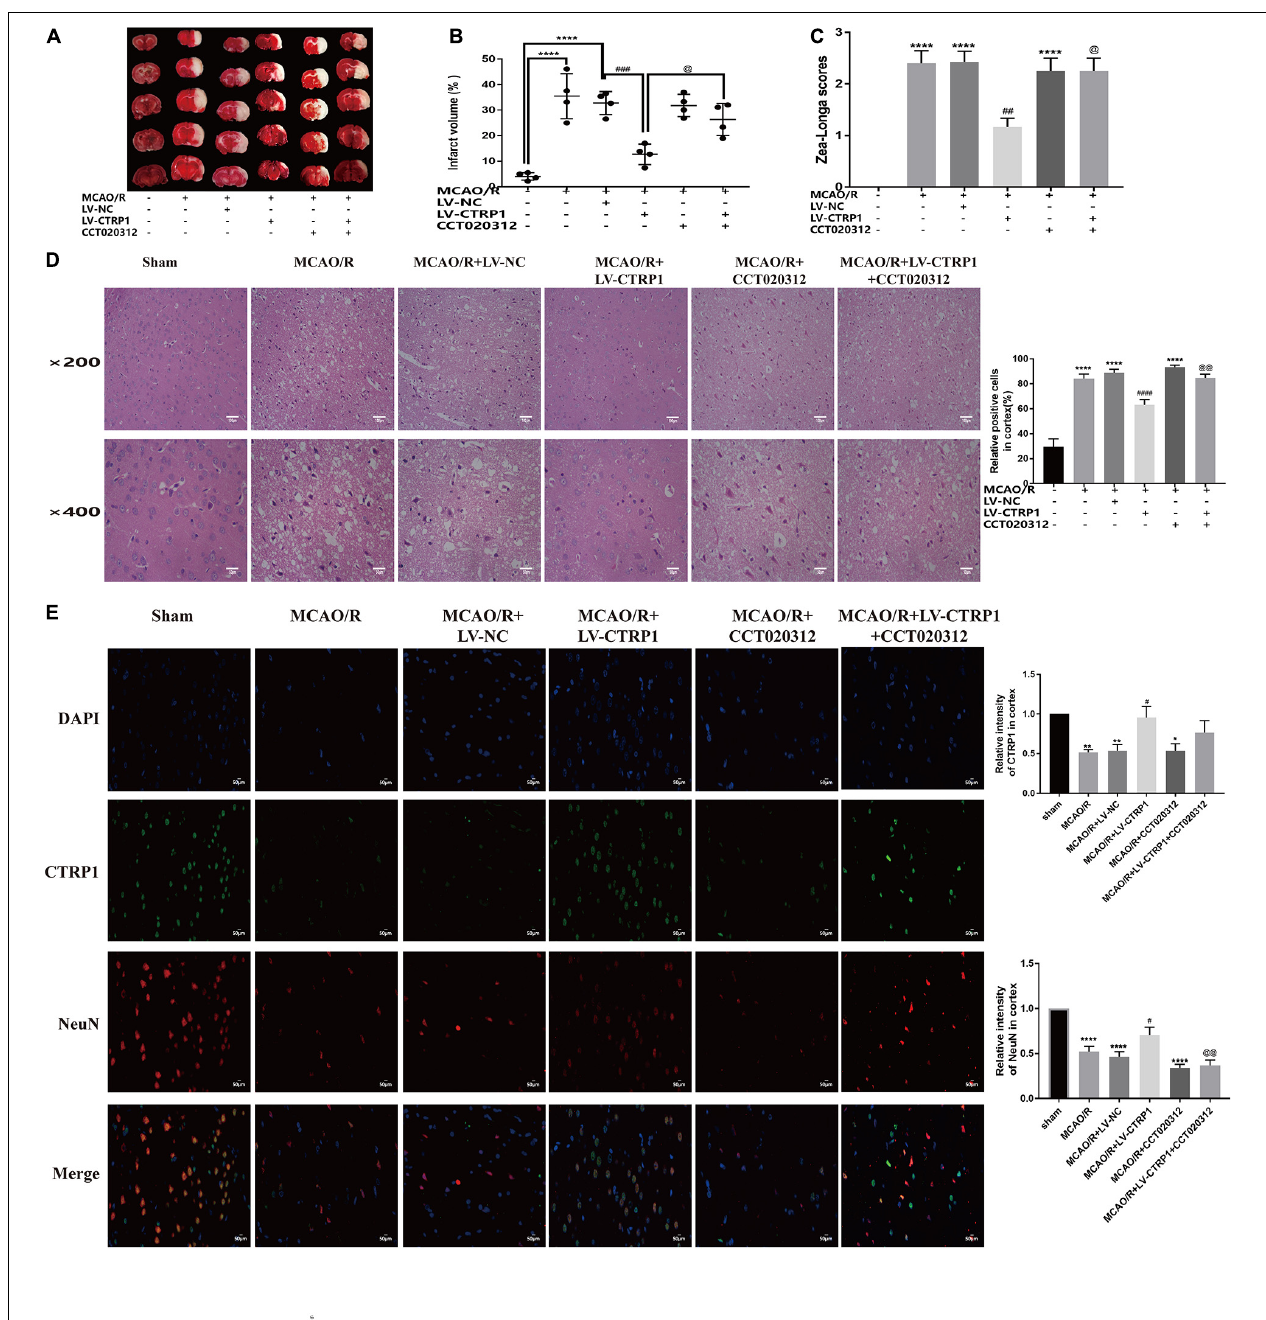
FIGURE 6 | The protective effect of CTRP1 in CIRI was abolished by CCT020312. (A,B) TTC staining and infarct volume in the brain. n = 4 per group. (C) Zea-longe scores. n = 13 per group. (D) HE staining and relative positive cells in the cortex. n = 3 per group. The representative images were acquired under × 200 magnification, scale bars = 100 µ m, × 400 magnification, scale bars = 50 µ m. (E) Double labeling immunofluorescence staining in the cortex ( × 400 magnification). n = 3 per group. The representative images were acquired under × 400 magnification, scale bars = 50 µ m. **** p < 0.0001, ∗∗ p < 0.01, * p < 0.05 vs. sham group, #### p < 0.0001, ### p < 0.001, ## p < 0.01, # p < 0.05 vs. MCAO/R + LV-NC group; @@ p < 0.01, @ p < 0.05 vs. MCAO/R + LV-CTRP1 group.